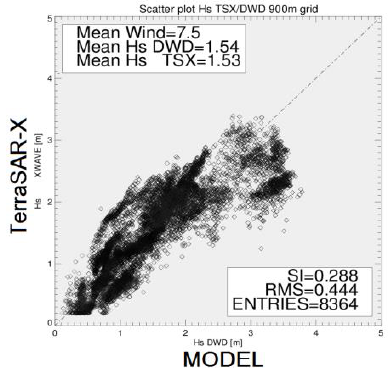
Figure 8. Total comparison of data set Tab.1 TerraSAR-X Figure 9. An example of comparison for wavelength derived from TS-X image and from CWAM model results from peak period and actual local depth using dispersion relation. TerraSAR-X wavelength (squares) are superimposed on the model